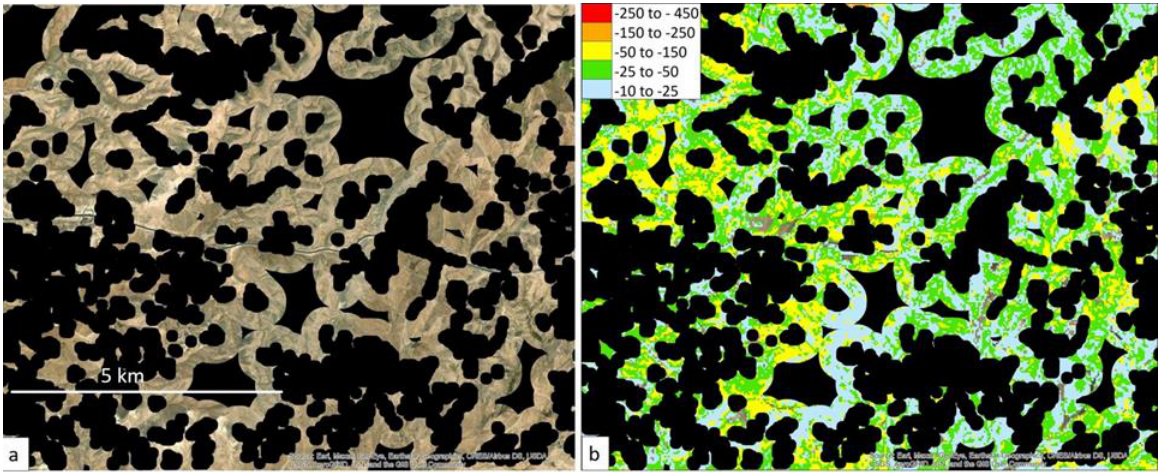
Figure 8. Differences in NPP in close proximity to small Bedouin settlements, 6 km E of Hura and 5 km N of Nevatim Air Force base (31°16.14′ N, 35°0.24′ E). ( a ) True color image with settlements masked; ( b ) LNS diff (gC m −2 yr −1 ).